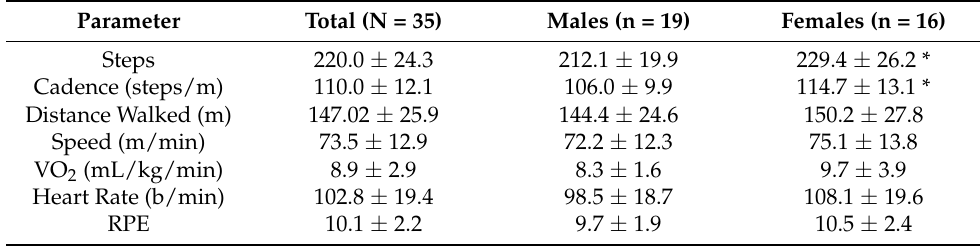
Table 2. Two-minute walk test outcome variables by